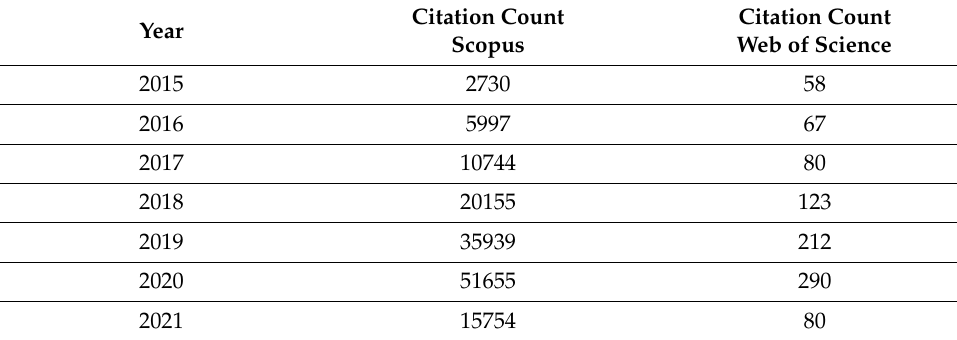
Table 16. Number of citations per year from Scopus and Web of Science.